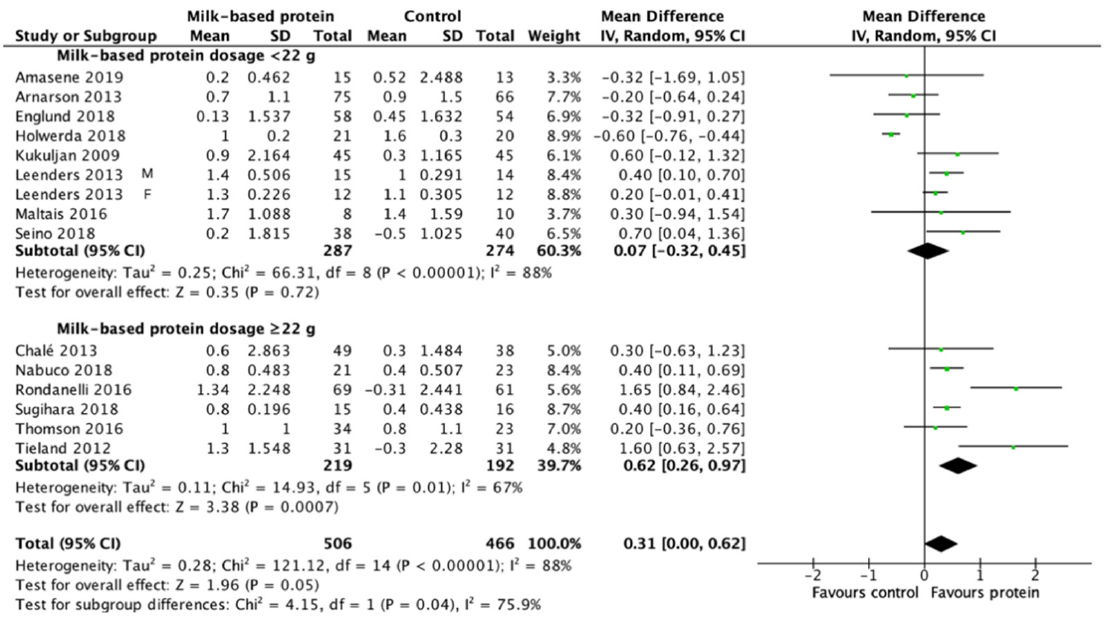
Figure 4. Forest plot for the differences in RT-induced LBM/FFM gain between consuming milk- based protein supplements and control supplements considering the subgroup analysis of daily dietary protein intake.